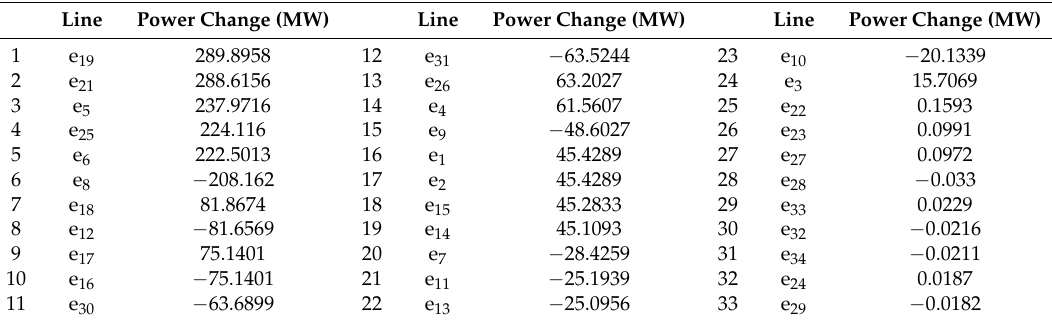
Table 2. Simulation result when line e 20 is removed.